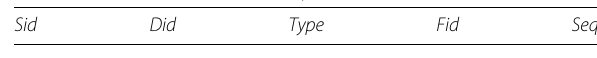
Fig. 5 The state machine of route maintenance